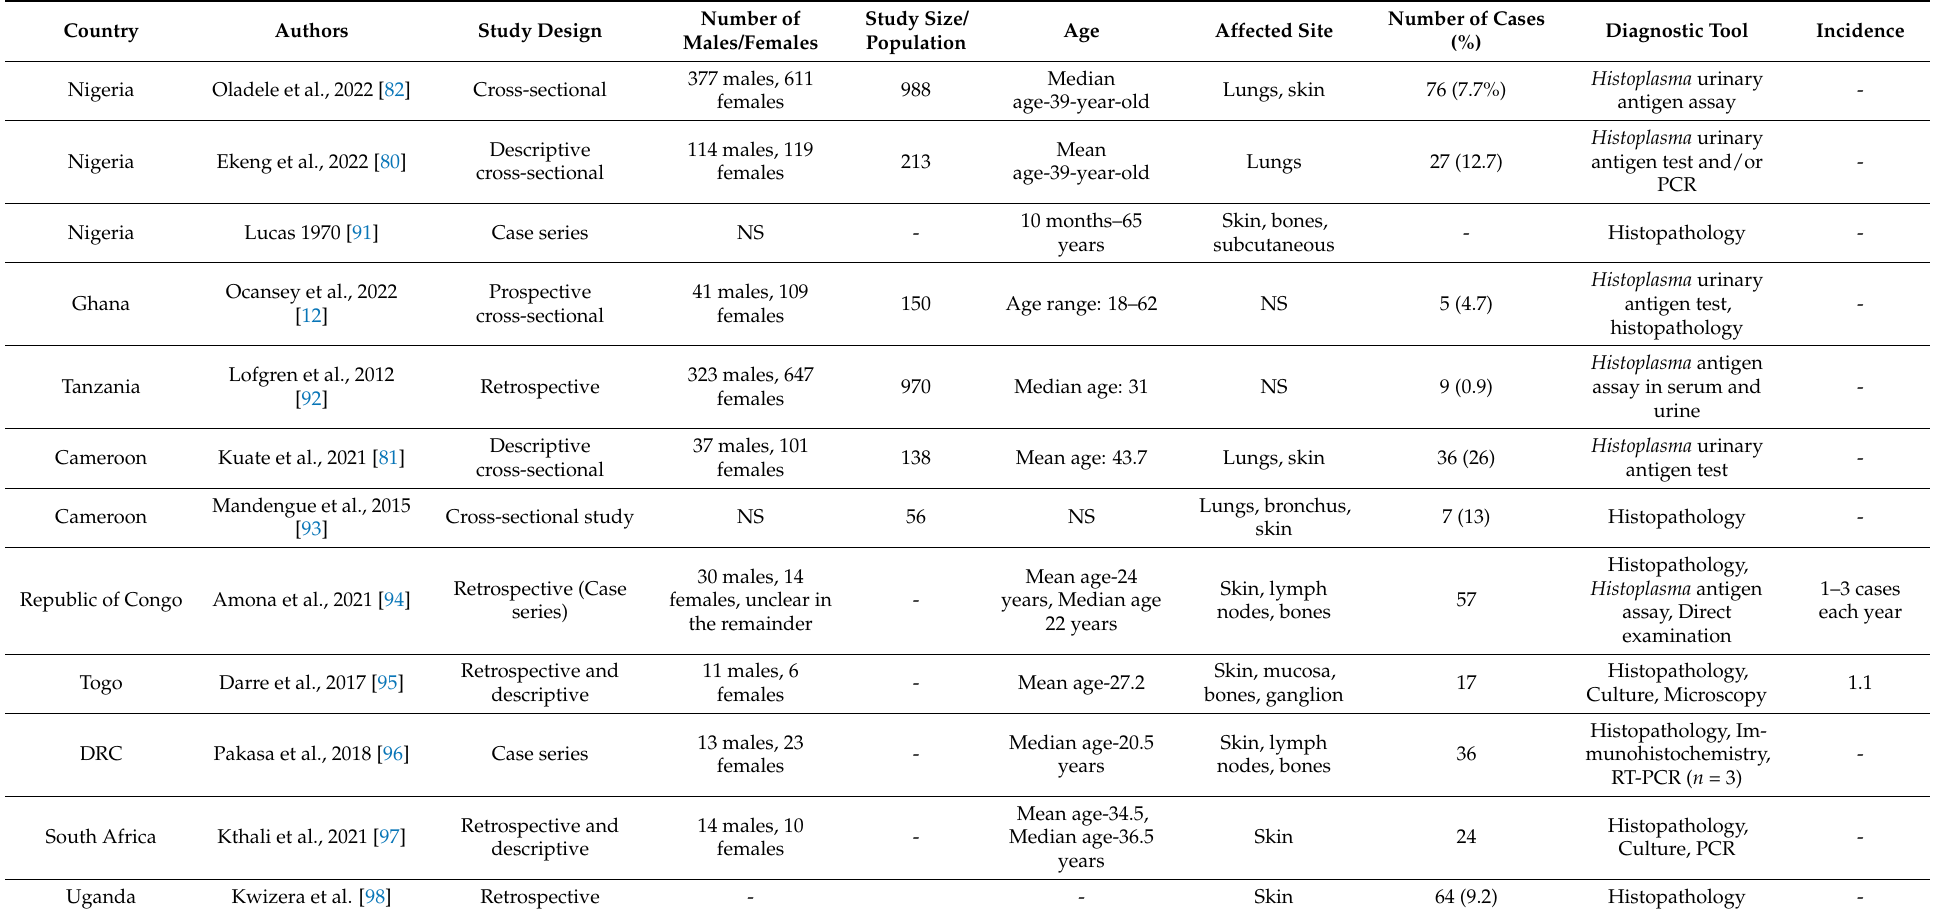
Table 3. Observational studies and case series on histoplasmosis from